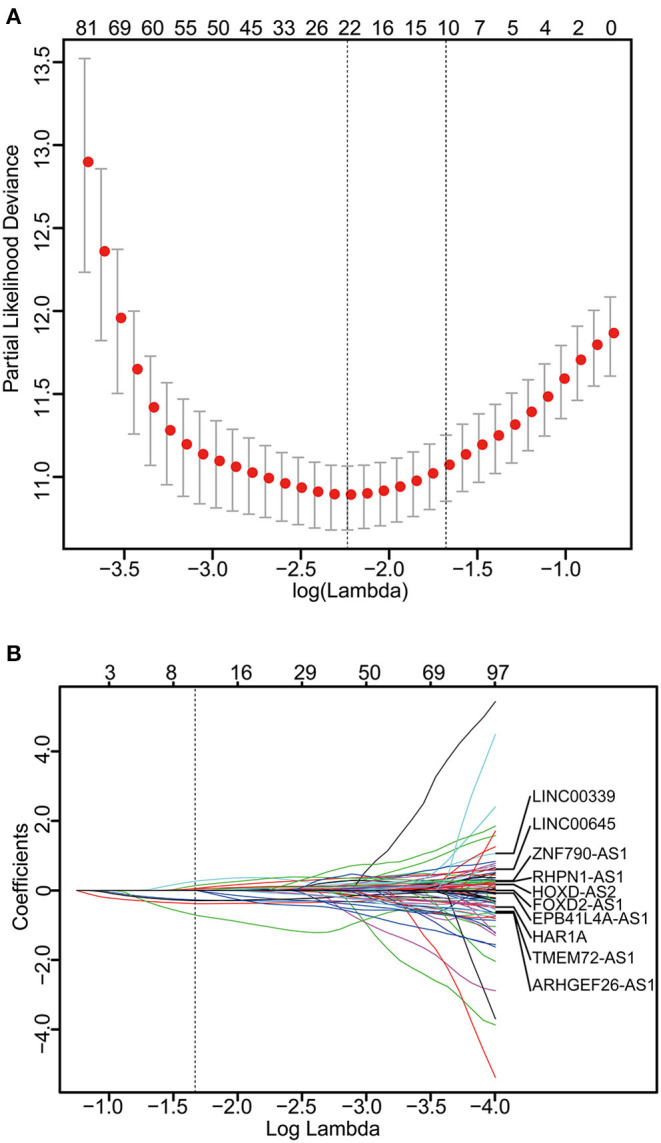
Construction of the 10-lncRNA-based classifier. (A) Ten-time cross-validation for tuning parameter selection in the LASSO model. The solid vertical lines are partial likelihood deviance ± standard error (SE). The dotted vertical lines are drawn at the optimal values by minimum criteria and 1-SE criteria. A λ value of 0.187 with log(λ) = −1.678 was chosen by 10-time cross-validation via 1-SE criteria. (B) LASSO coefficient profiles of the 176 glioma-prognosis-associated lncRNAs. A dotted vertical line is drawn at the value identified by 10-fold cross-validation.